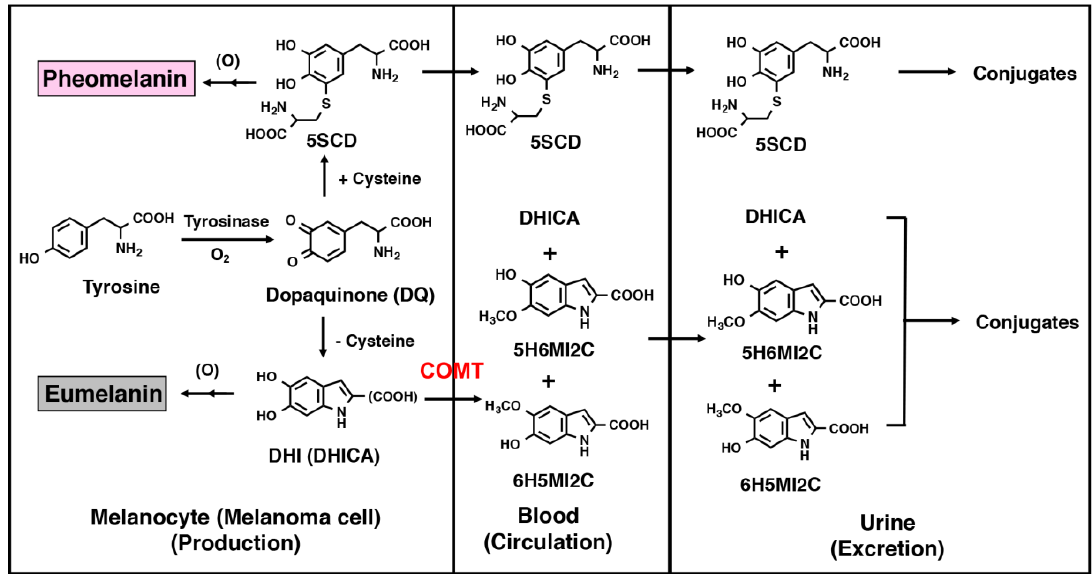
Figure 1. Production, circulation, and excretion of melanin-related metabolites. 5- S -cysteinyldopa (5 S CD); 5,6-dihydroxyindole (DHI); 5,6-dihydroxyindole-2-carboxylic acid (DHICA); catechol- O - methyl transferase (COMT); 5-hydroxy-6-methoxyindole-2-carboxylic acid (5H6MI2C); 6-hydroxy-5- methoxyindole-2-carboxylic acid (6H5MI2C).